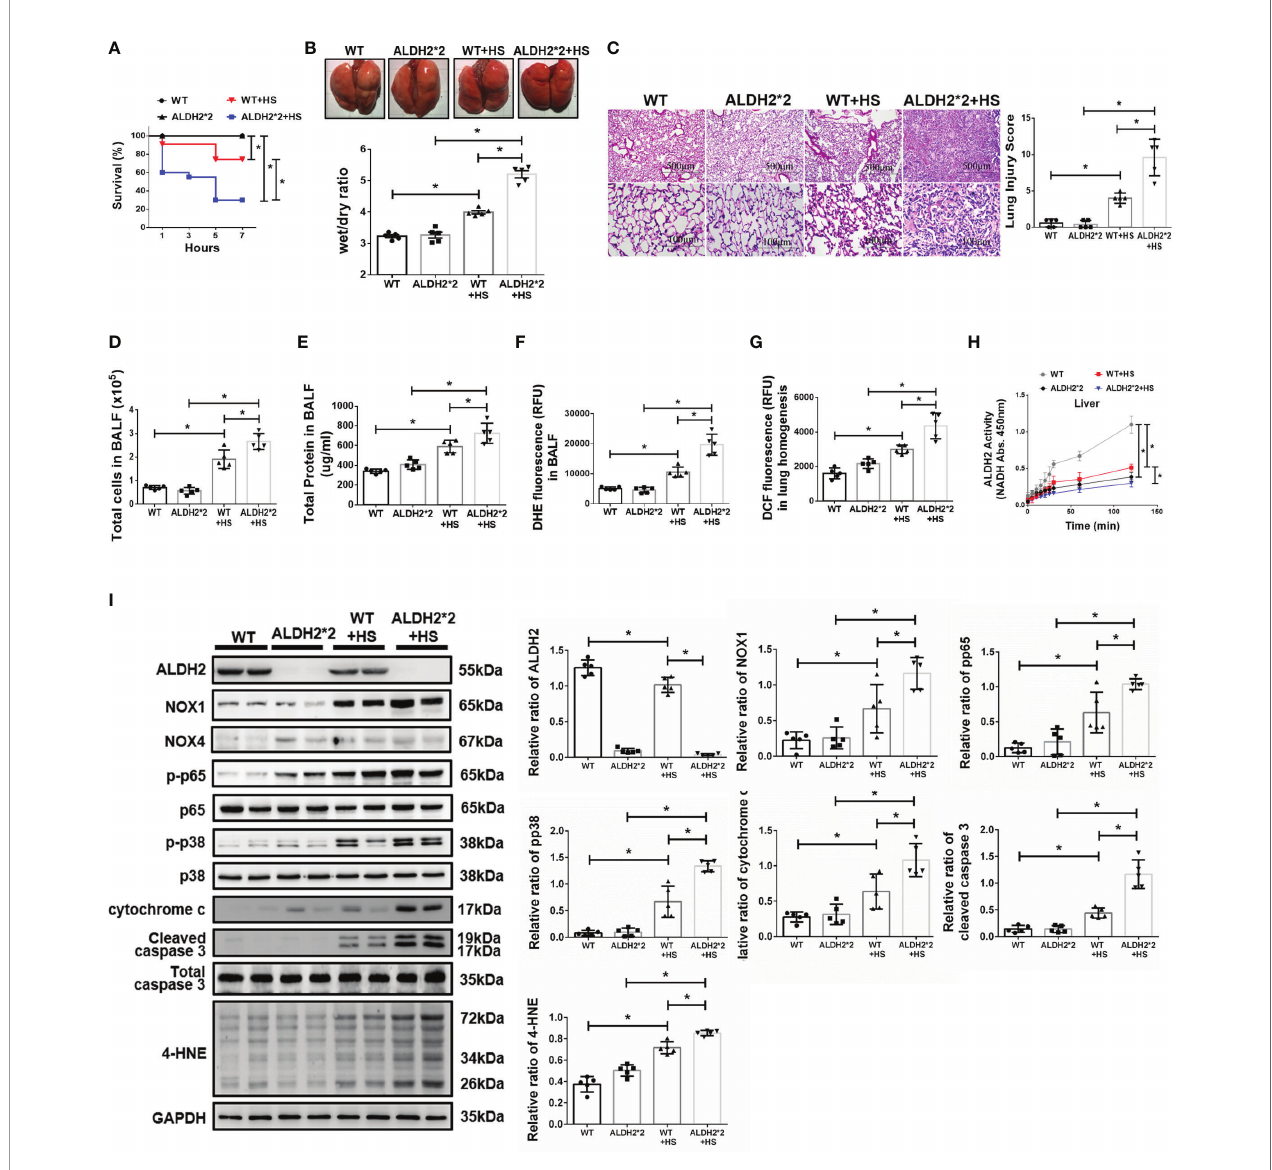
FIGURE 1 | Effects of ALDH2 on HS-induced ALI in vivo . C57BL/6J WT and ALDH2*2 KI mice were exposed to WBH (42°C, 80% RH for 1 h) and then analyzed. (A) Survival of mice subjected to WBH ( n = 20 in each group). (B) Representative images of the lungs and wet/dry ratio of the lungs ( n = 5). (C) H&E stain of the lungs ( n = 5). (D) Total cells in the BALF ( n = 5). (E) Total protein in the BALF ( n = 5). (F) ROS production in the BALF as determined by DHE fl uorescence measurement using a fl uorescence microplate reader with an excitation wavelength of 518 nm and an emission wavelength of 606 nm ( n = 5). (G) ROS production in lung homogenates as determined by DCF fl uorescence measurement using a fl uorescence microplate reader with an excitation wavelength of 488 nm and an emission wavelength of 535 nm ( n = 5). (H) The ALDH2 activity in liver homogenates was measured by NADH production using the O.D. absorbance at 450 nm in a microplate reader ( n = 5). (I) The protein and 4-HNE levels in lung homogenates were measured by immunoblotting. Densitometric analysis was conducted with imaging processing software. The data were quanti fi ed by normalization to GAPDH; phosphorylated proteins were normalized to total proteins ( n = 5). The data are expressed as the mean ± SD. Statistical signi fi cance is indicated as * p <